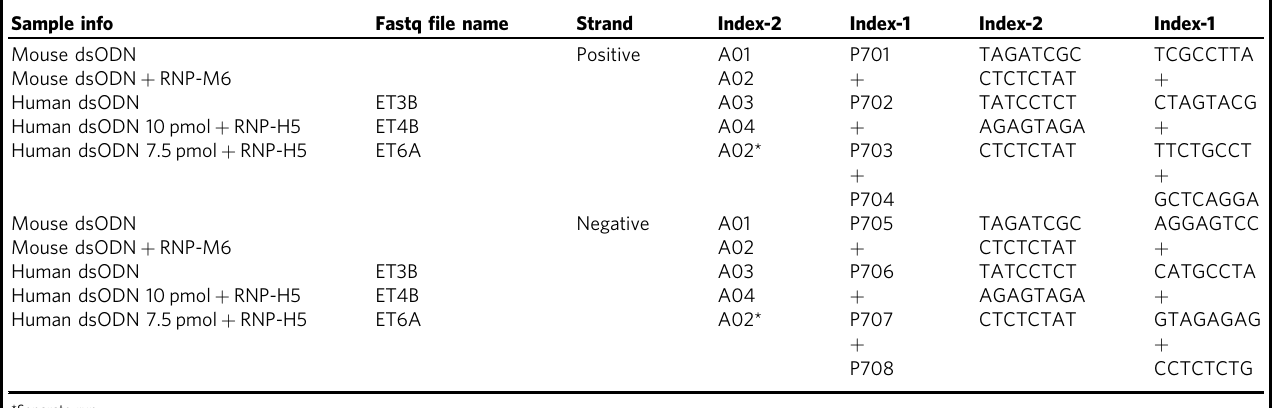
Table 2 GUIDE-Seq library set